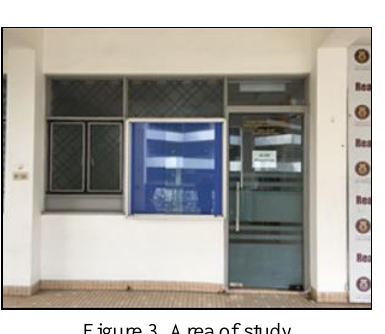
Figure 2. Flowchart of study